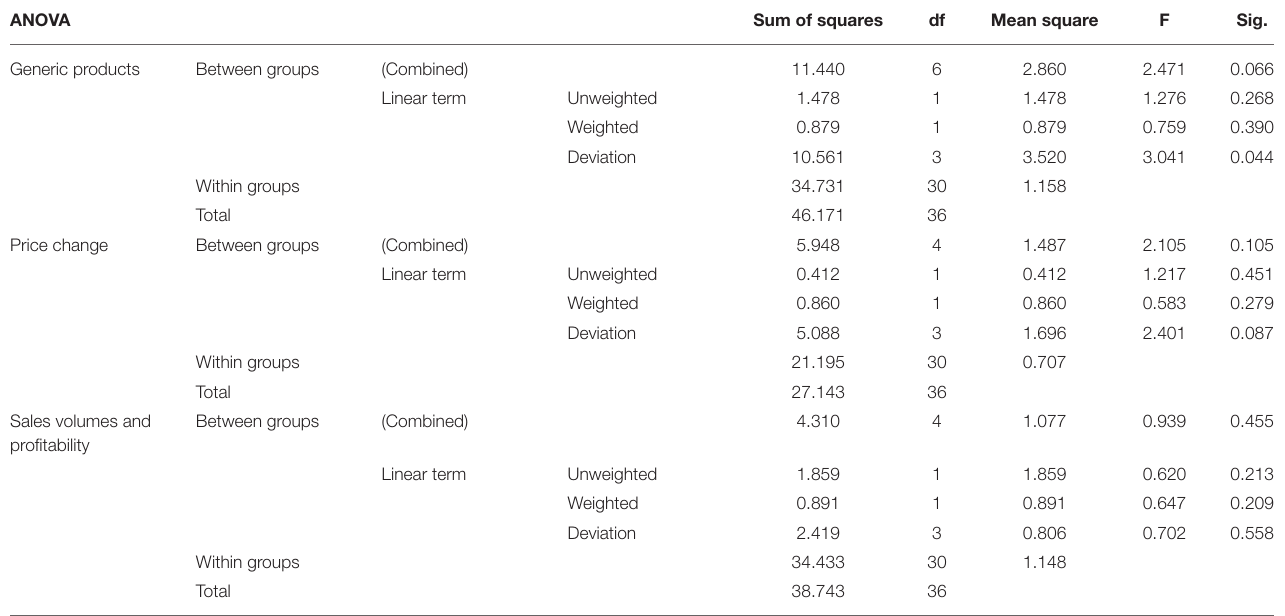
TABLE 6 | Analysis of variance. ANOVA Sum of squares df Mean square F